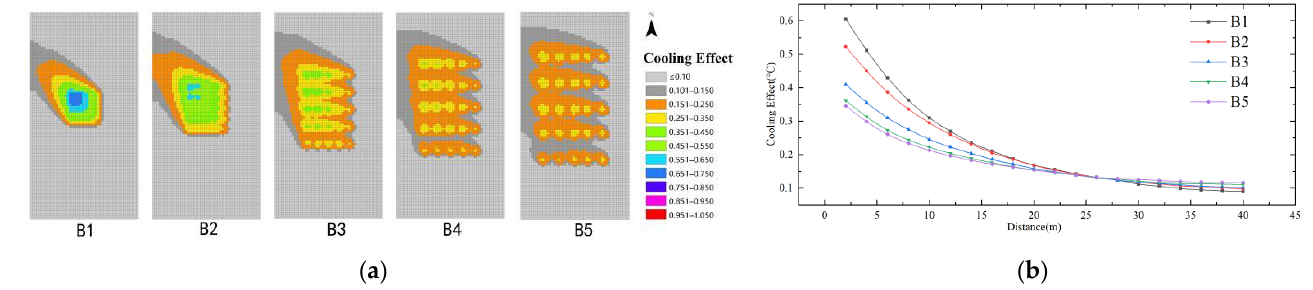
Figure 13. Cooling effect of the water body dispersion index: ( a ) Impact distribution map; ( b ) Impacts with distance.